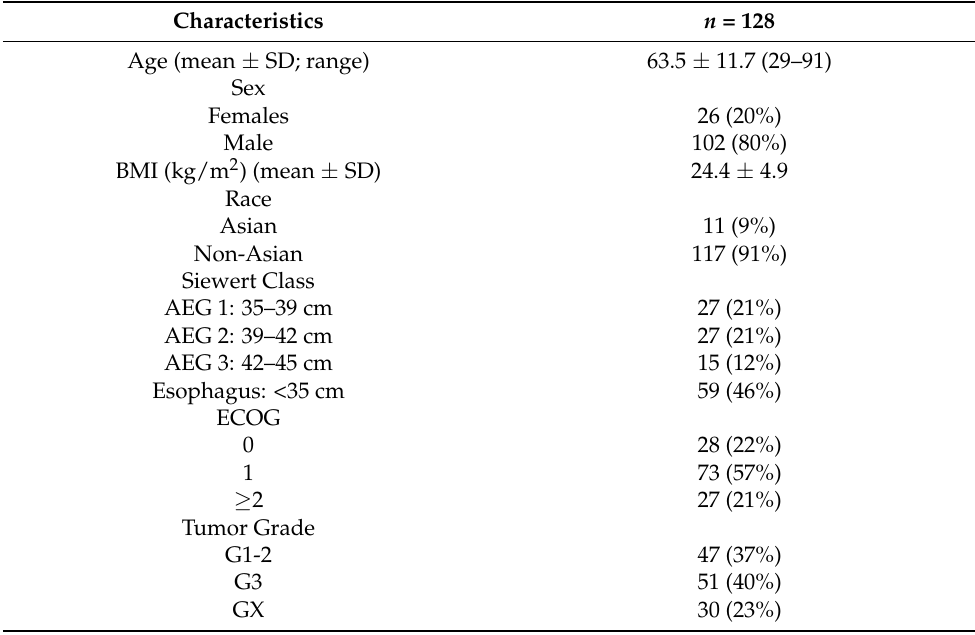
Table 1. Demographic data of the study